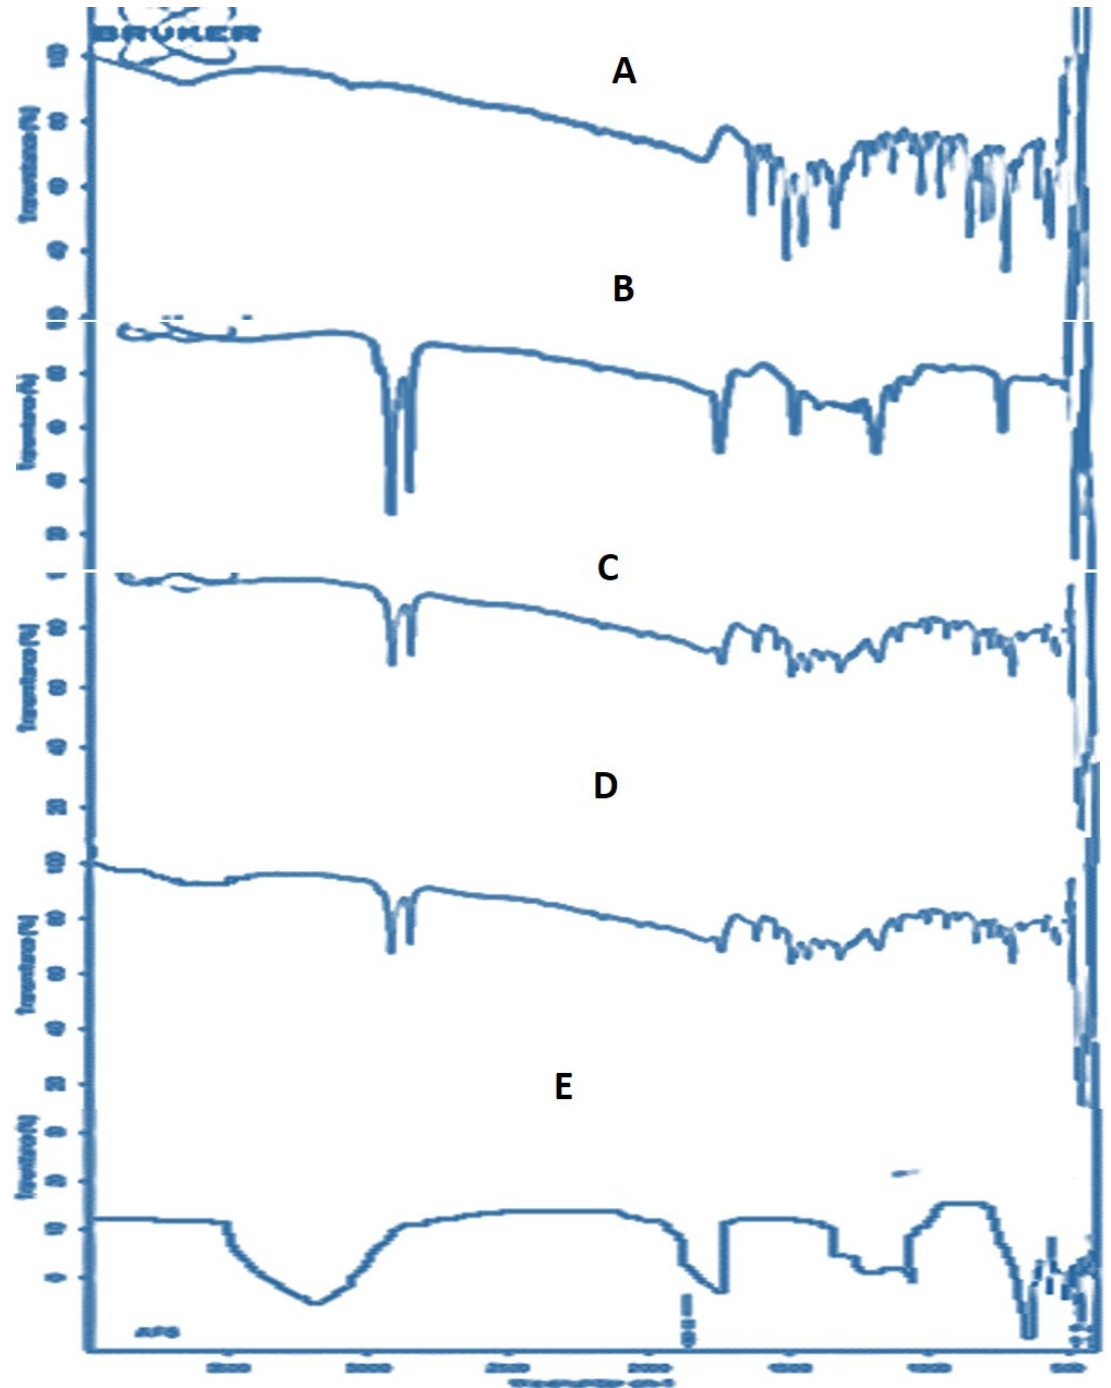
Figure 5. FTIR spectrum of ( A ) pure alprazolam ( B ) compritol 888 ATO ( C ) Tween 20 ( D ) physical mixture (ALP + compritol) ( E ) AF6.